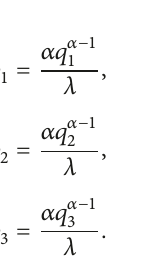
= 12 , 𝑘 = 12 , 𝑘 = 14 , 𝑐 = 0.19 , 𝑐 = 0.18 , and 𝑐 = 0.17 1 2 3 1 2 3